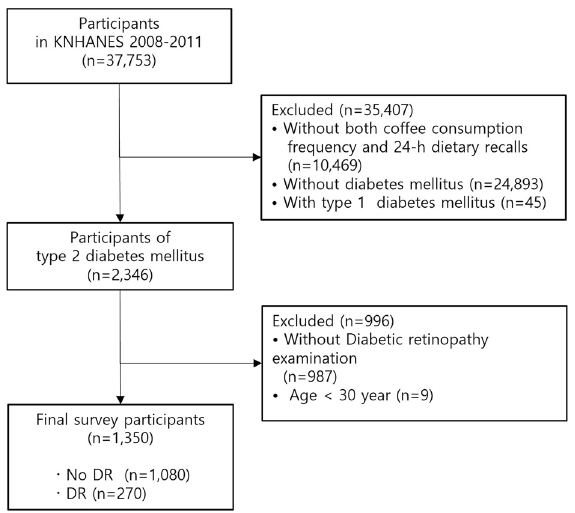
Figure 1. Flowchart of the study participants diagnosed with type 2 diabetes who underwent diabetic retinopathy examination. (KNHANES: Korea National Health and Nutrition Examination